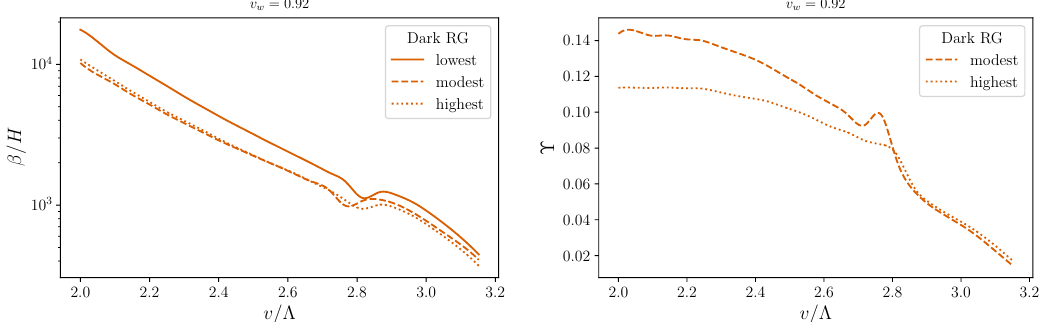
Figure 8 . Dark RG : the inverse time duration of the phase transition at the different levels of diligence using eq. [(2.6), (2.13), (2.37)]. The lowest and modest diligences are estimated using the first derivative of the action dS/dT and the highest diligence is computed directly from the mean bubble separation. The right panel shows the suppression factor due to the lifetime of the source using eq. (2.14) and eq. (2.60) for modest and highest diligence respectively. The lowest diligence corresponds to Υ → 1 . The temperatures are set to T modest, and highest diligence